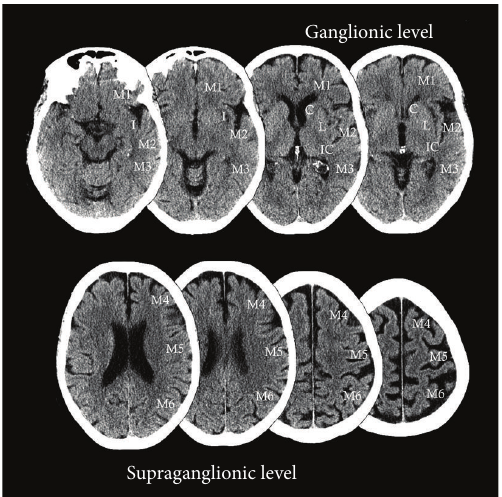
Figure 1: Obtained from http://www.aspectsinstroke.com/, demonstrating the ASPECTS scoring methodology, axial NCCT images showing the MCA territory regions as defined by ASPECTS. C, caudate, I, insularribbon, IC, internal Capsule, L, lentiform nucleus, M1, anterior MCAcortex, M2, MCA cortex lateral to the insular ribbon, M3, posteriorMCA cortex, M4, M5, M6 are the anterior, lateral, and posterior MCAterritories immediately superior to M1, M2, and M3, rostral to basal ganglia. Subcortical structures are allotted 3 points (C, L, and IC). MCA cortex is allotted 7 points (insular cortex, M1, M2, M3, M4, M5, and M6). (Reprint permission obtained from Dr. Mayank Goyal, professor of radiology and clinical neurosciences, Foothills Medical Centre, University of